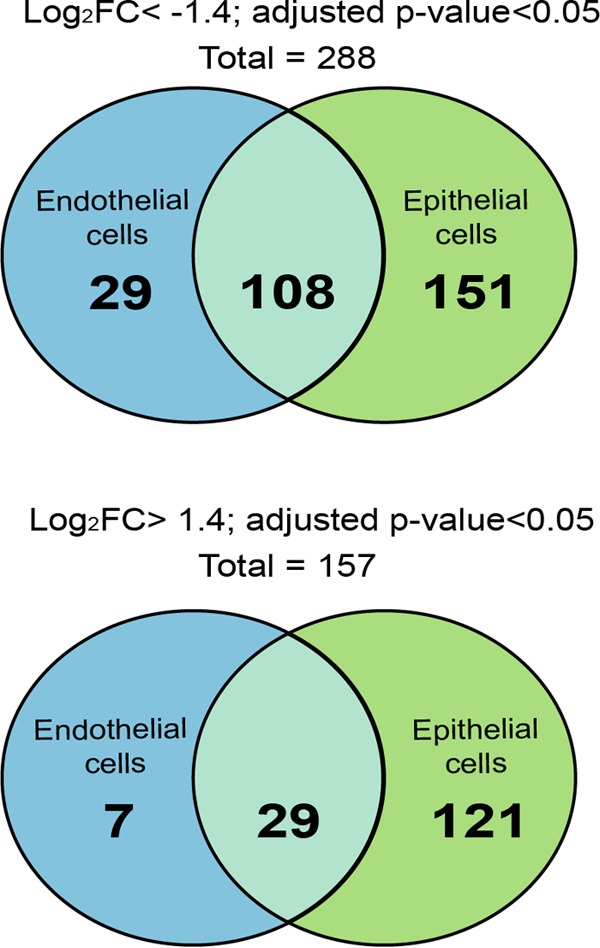
Identification of conditional essential genes necessary for colonization of epithelial and endothelial cells. The Venn diagram shows the absolute number of necessary ORFs (log2 FC < −1.4; adjusted P < 0.05) and beneficial ORFS (log2 FC > 1.4; adjusted P value < 0.05). (ORFs were selected in both the epithelial cell and endothelial cell in vitro models.)